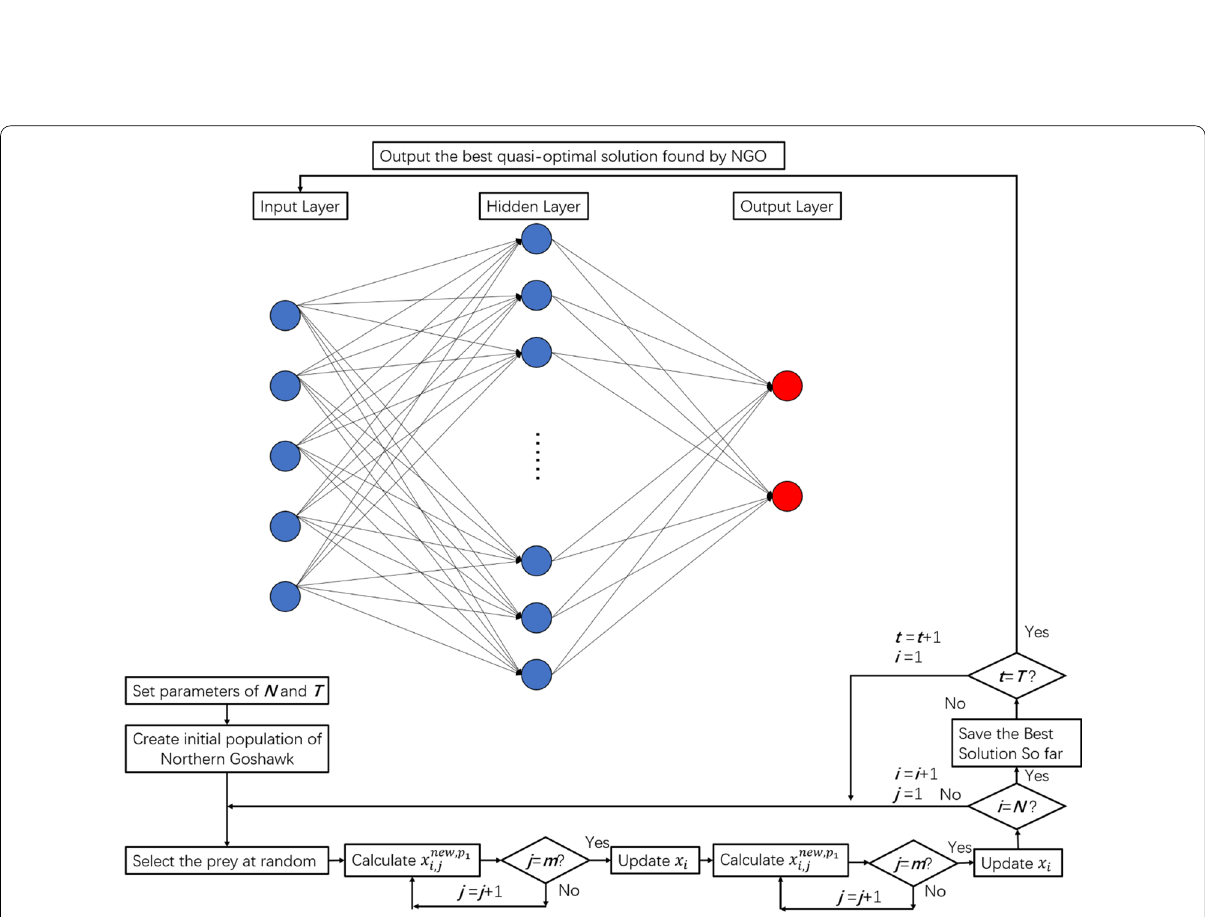
Fig. 4 The mean plasma concentration–time curves of NSCLC patients in different dose groups after multiple dosing of MET306. * The Mean plasma concentration–time profile of MET306 in human plasma following multiple oral administration of MET306 in different dose groups ( A : 10 mg, B : 20 mg, C : 30 mg, D : 45 mg, E : 60 mg, F : 80 mg, G : 105 mg, H : 140 mg) to NSCLC patients ( A : n n 4, G : n 5, H : n 1) = = =